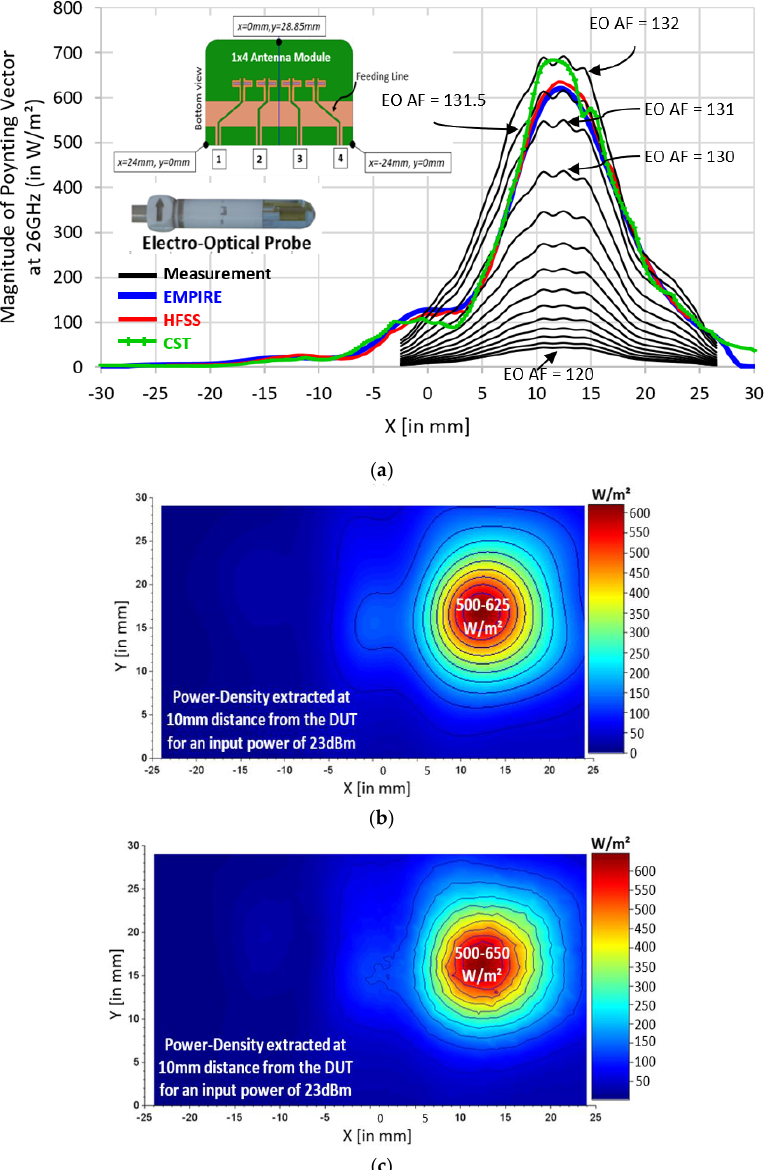
Figure 8. Measured ( a ) power-density as function of electro-optical (EO) probe sensitivity (from 132 dB/m to 120 dB/m) at 26 GHz: comparison with 3D full-wave EM solvers (CST ( a ), EMPIRE ( b ) and HFSS ( c )).